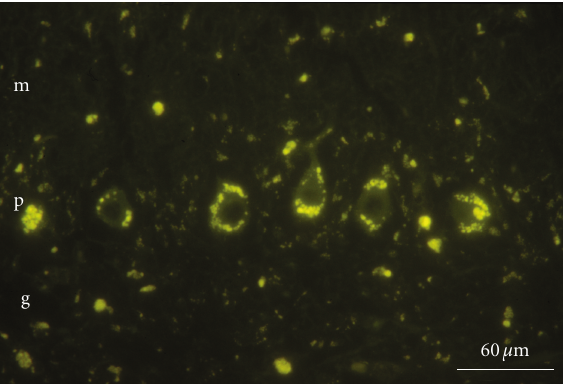
Figure 5: Fluorescence micrograph of the cerebellum from an Australian Shepherd with NCL that tested homozygous for the T allele at the c.829 locus [4]. The layers of the cerebellum are labeled as follows: g: granular layer; p: Purkinje layer; m: molecular